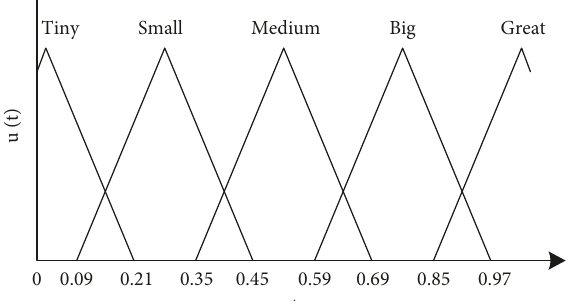
Table 4: Simulation parameters at different impact i .